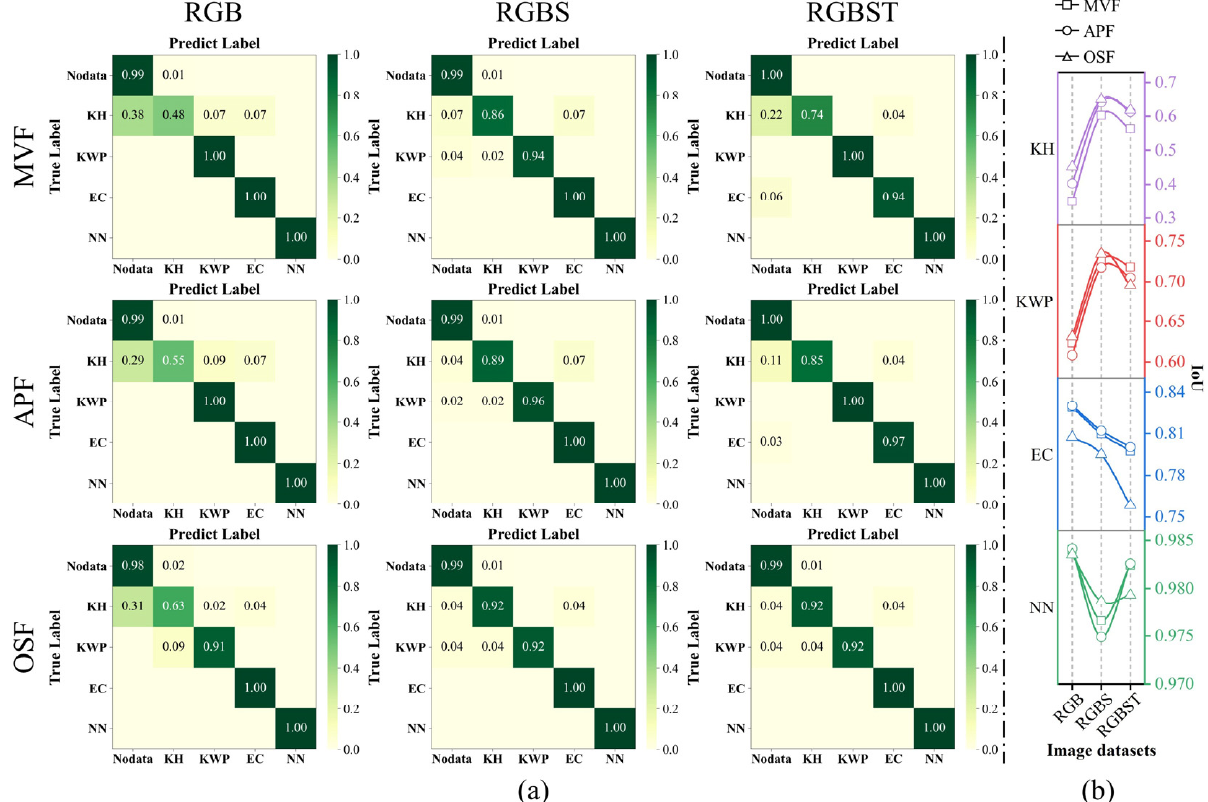
Figure 15. Comparison of the classification accuracies of OC-FCMs with different image datasets for karst wetland vegetation. ( a ) Normalized confusion matrix, ( b ) IoU.